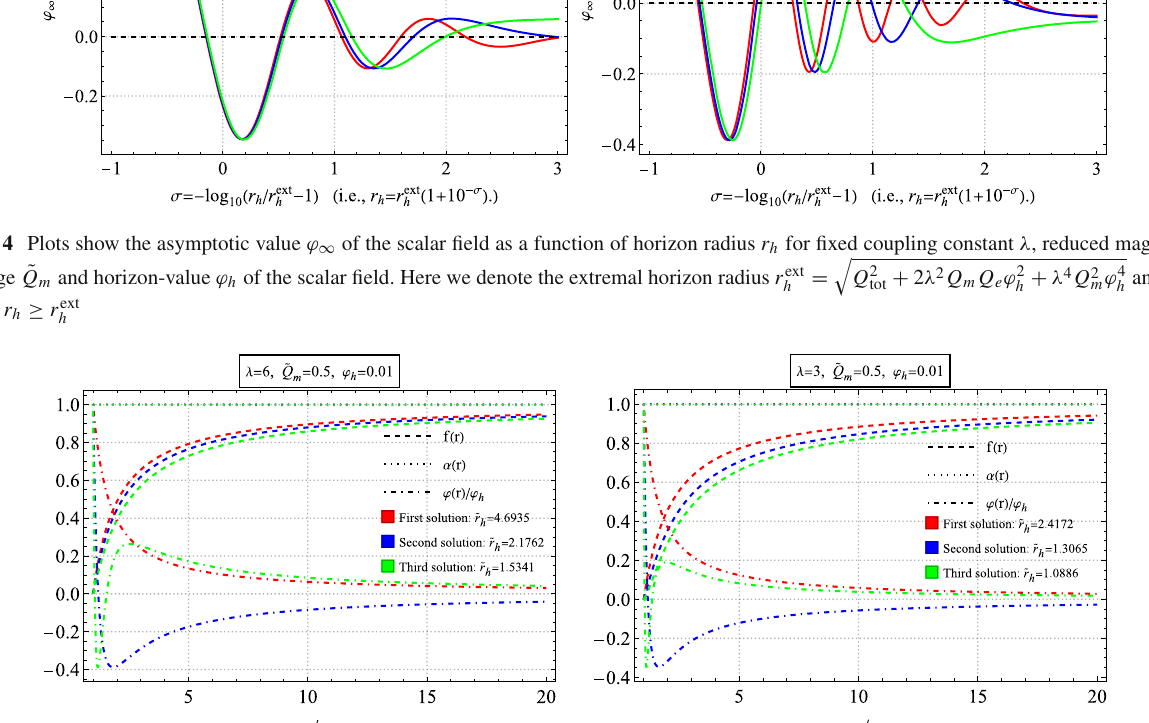
Fig. 5 Plots show the behaviors of metric functions and scalar field as a function of r / r h with the fixed λ , ˜ Q m and ϕ h for the first three solutions of scalarized dyonic RN black